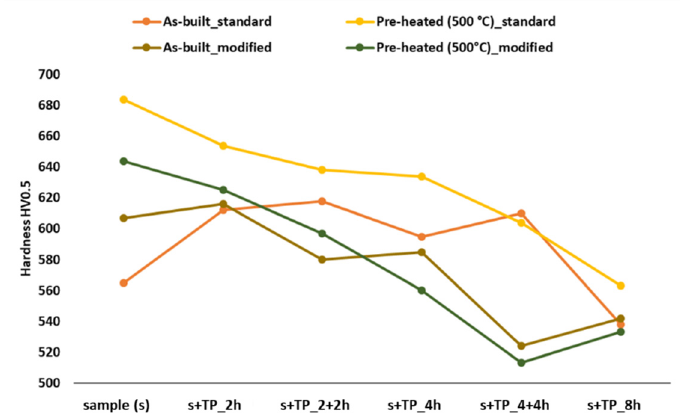
Figure 11. The microhardness graph of the modified and standard 1.2343: as-built, preheated (500 °C), tempered (TP) at 550 °C one time (1×) or two times (2×) for 2 h, 4 h, and 8 h.